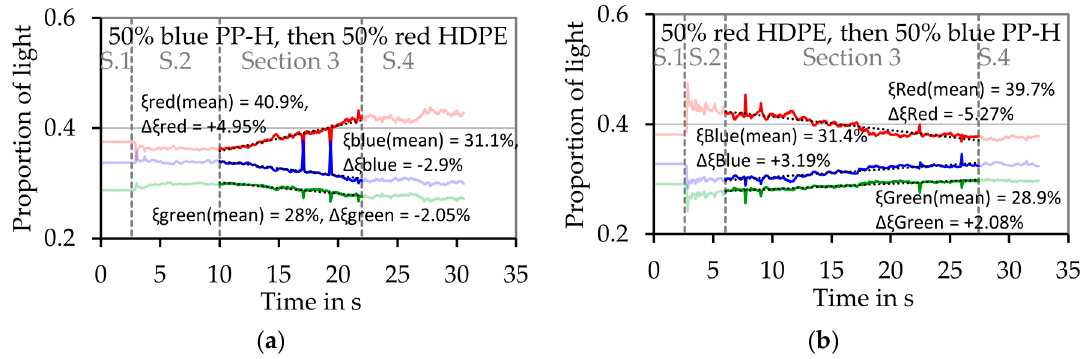
Figure 16 . Results of the optical evaluation of the melting experiment for two different polymers. The dashed line shows the transitions between the four sections. ( a ) Filling sequence: First pure blue PP-H, grade B; then pure red HDPE, ( b ) filling sequence: First pure red HDPE, then pure blue PP-H.